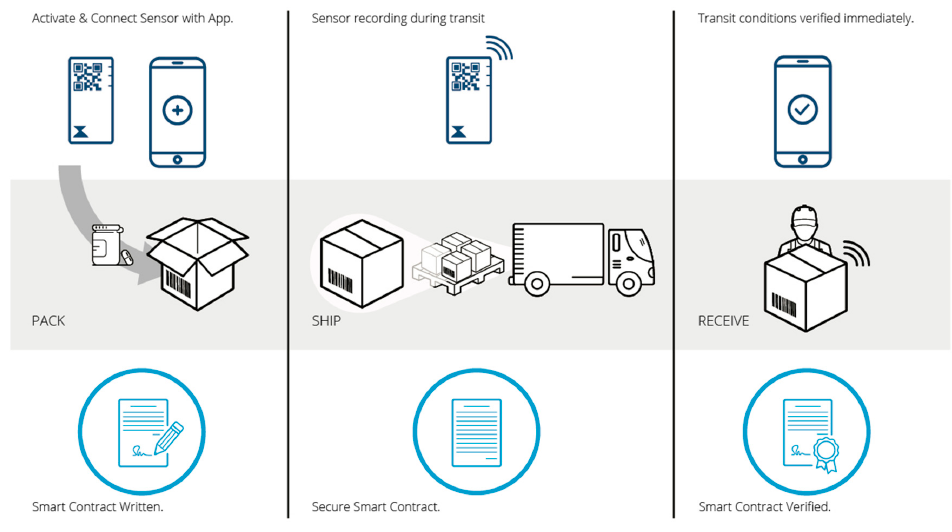
Figure 6. Logistics process of the company Modum [40] (p. 8).